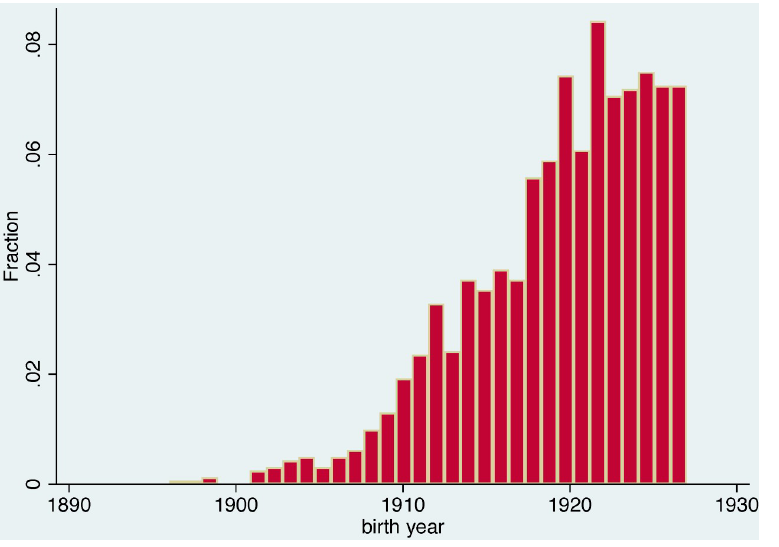
Fig 1. Distribution of year of